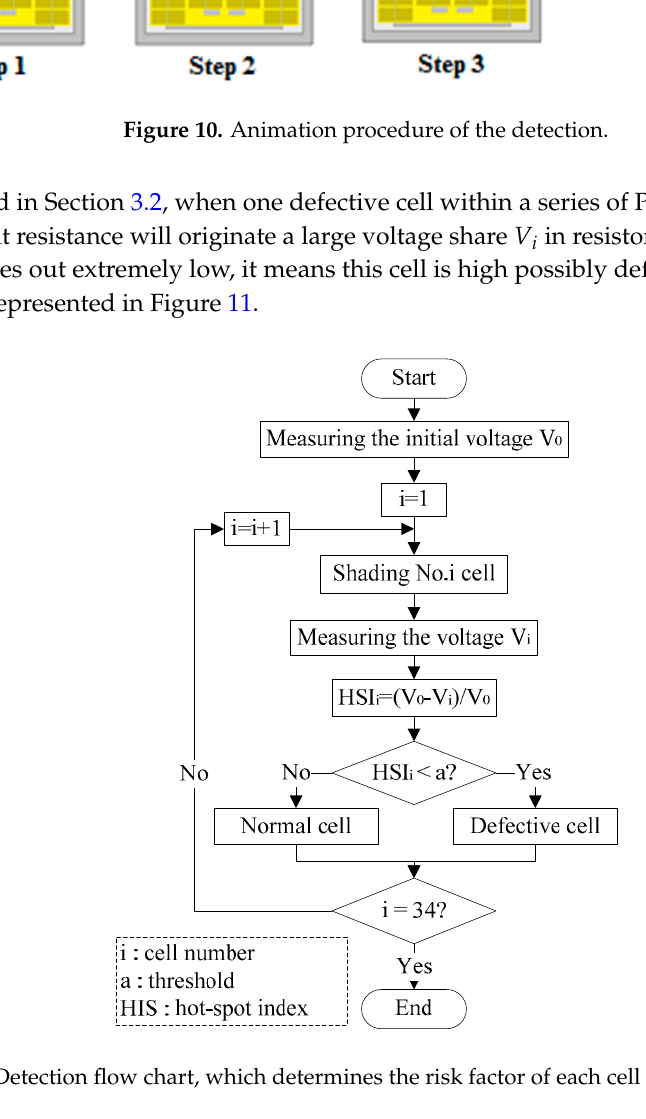
Figure 10. Animation procedure of the detection.